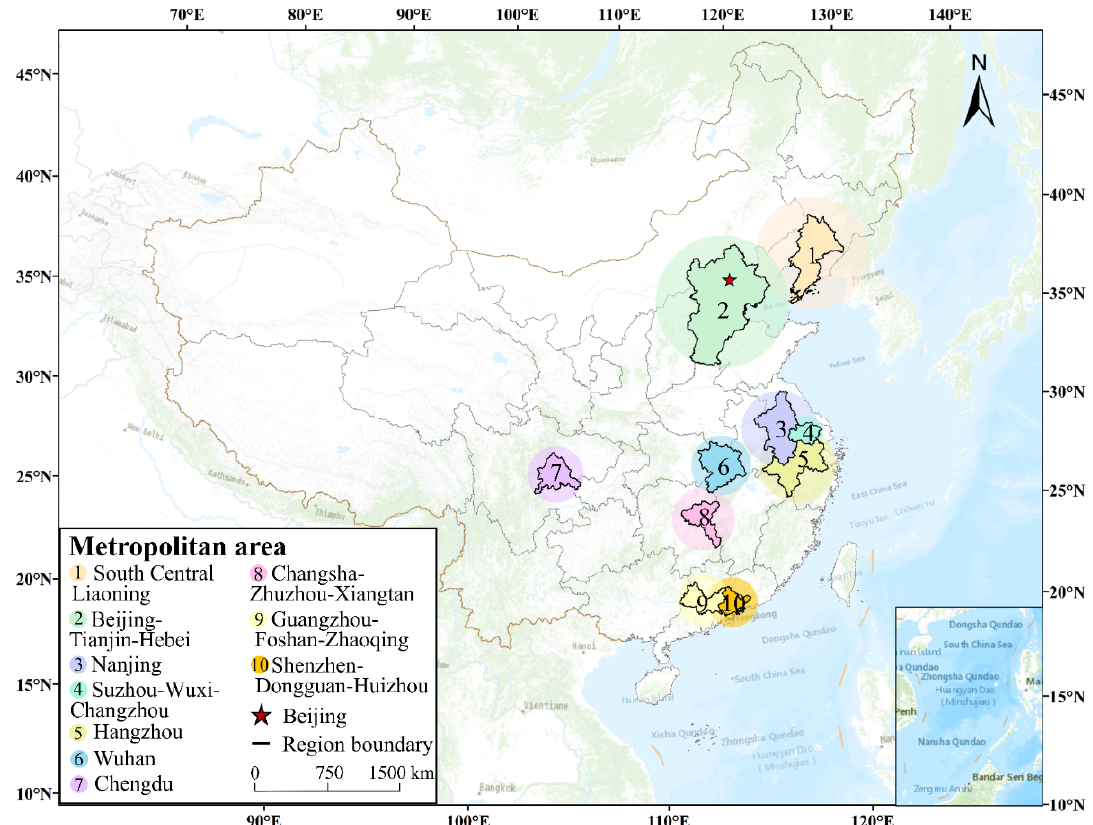
Figure 1. Distribution of ten metropolitan areas in China.